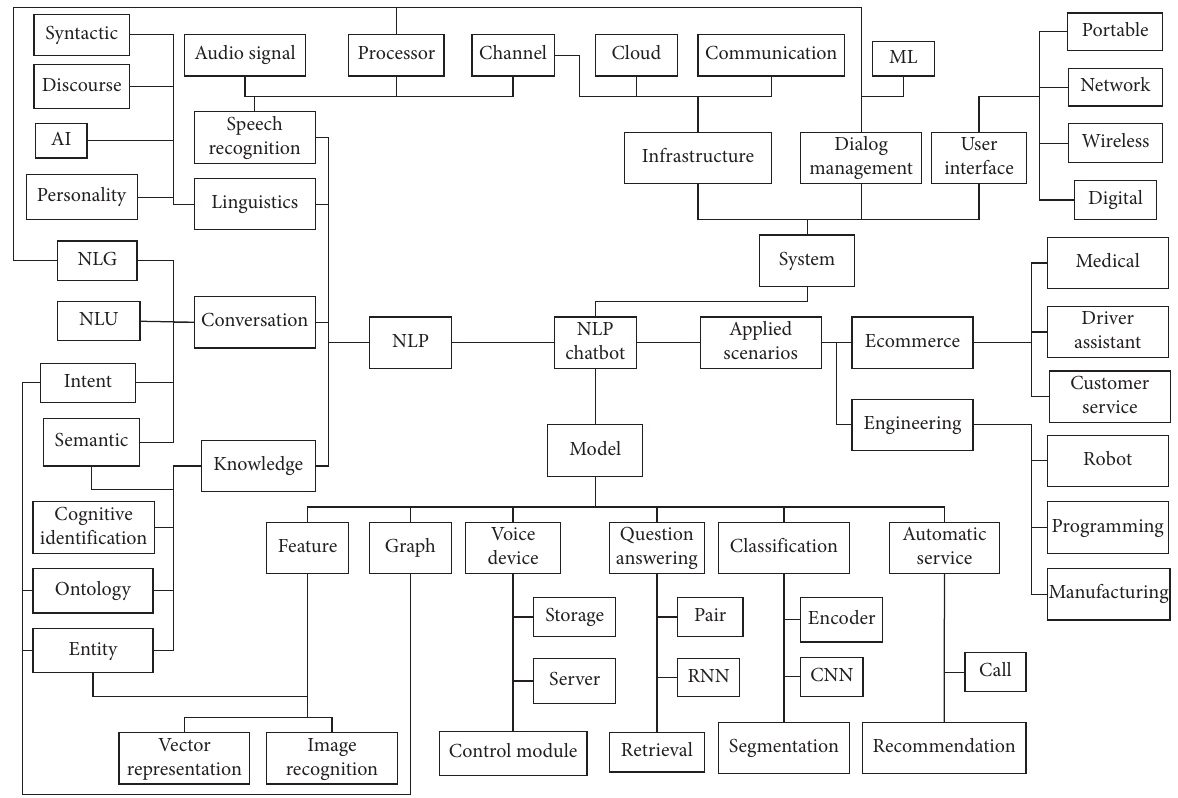
Figure 2: NLP chatbot Table 8: Search query for patent management analysis.